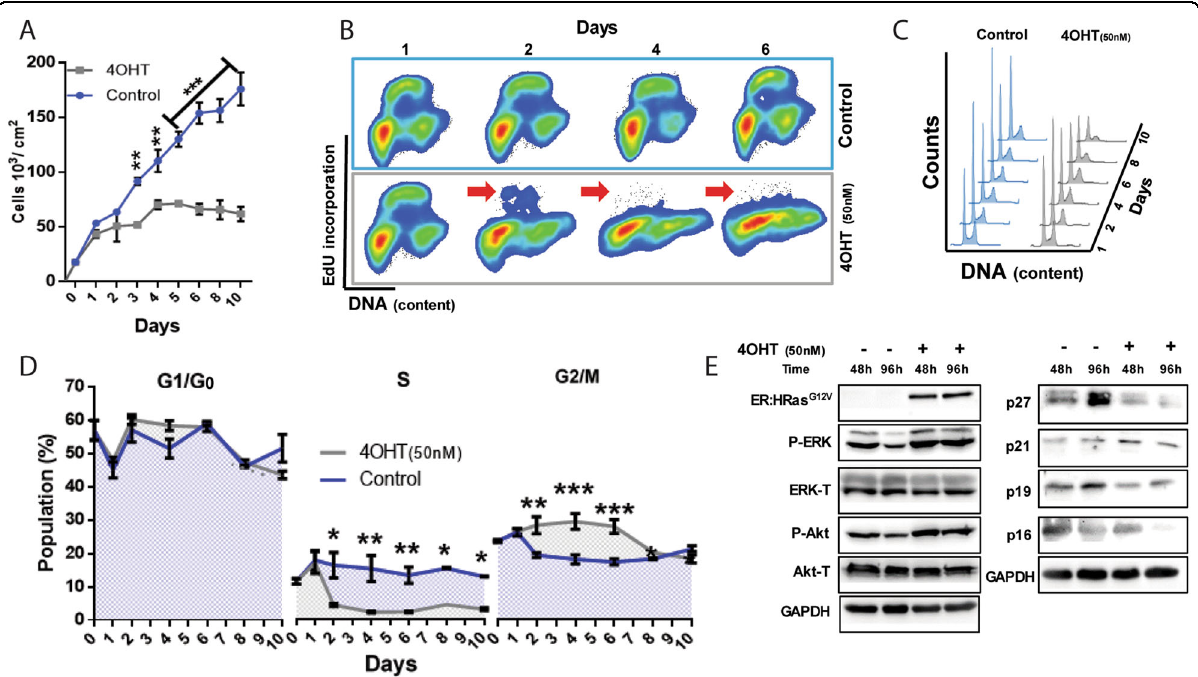
Fig. 2 Oncogenic stress induced by high HRas G12V activity in E6E7 keratocytes causes cell cycle arrest at G1/G0 and G2/M phases. A Growth curve of ER:HRas G12V keratinocytes in the supplemented medium induced or not with 50 nM of 4OHT. The graph is representative of three independent experiments carried out in triplicate. B Cell cycle pro fi le analyses of growing ER:HRas G12V keratinocytes, using 1-h pulse of EdU incorporation and propidium iodide (PI) staining, showed a progressive decrease in DNA synthesis (red arrows) in cells induced with 50 nM 4OHT. C DNA content pro fi les of growing ER:HRas G12V keratinocytes stained with PI, with or without 4OHT induction. D Steady-state growing ER:HRas G12V keratinocytes were induced or not with 50 nM 4OHT at zero time: kinetics of the relative size of cell cycle-phase subpopulations; evidence of cell cycle arrest at G1/G0 and G2/M phases only in 4OHT-induced cells. The graph is representative of four independent experiments, two PI single-labeled, and two PI plus EdU double-labeled. All conditions and time points were carried out in duplicate. E Immunoblots showed intracellular levels of critical components of cell cycle control pathways in growing ER:HRas G12V keratinocytes induced or not with 4OHT. For fl ow cytometry, 30 × 10 3 cells